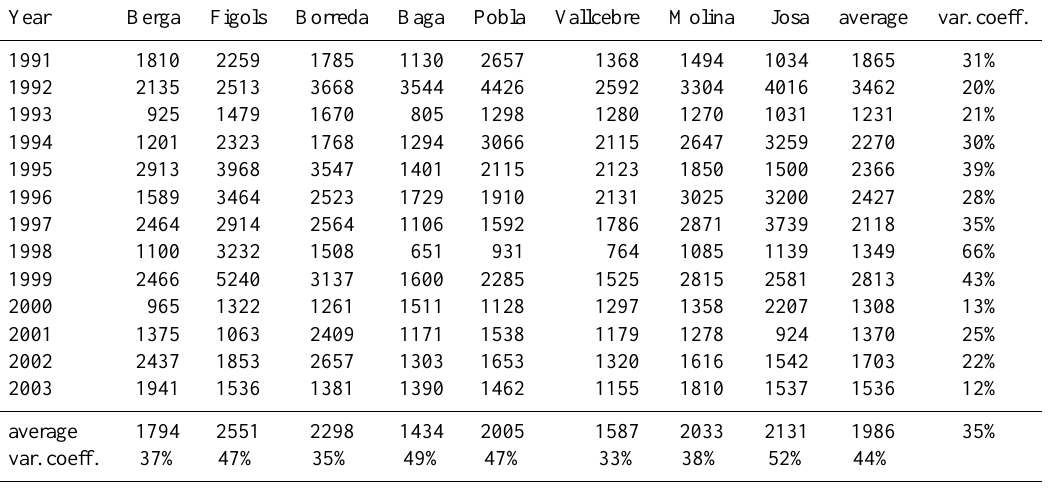
Table 3. Annual rainfall erosivity values obtained at the stations (MJmmha − 1 yr − 1 ).